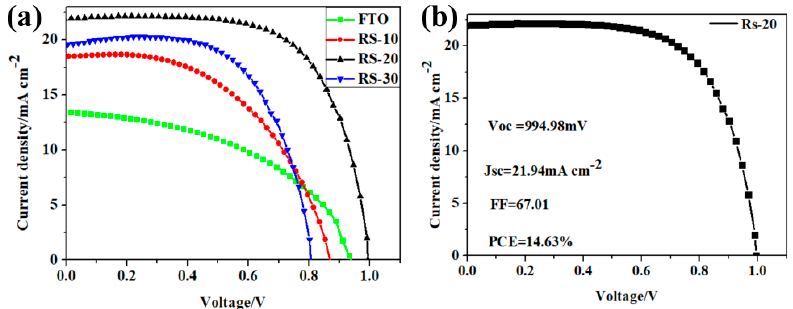
Figure 5. J – V average curves of different planar perovskite solar cells (PSCs) ( a , b ) J – V curve of the best planar PSC based on room temperature reactive sputtering of SnO 2 . Table 1. Average photoelectric parameters of PSCs with di ff erent reaction sputtering